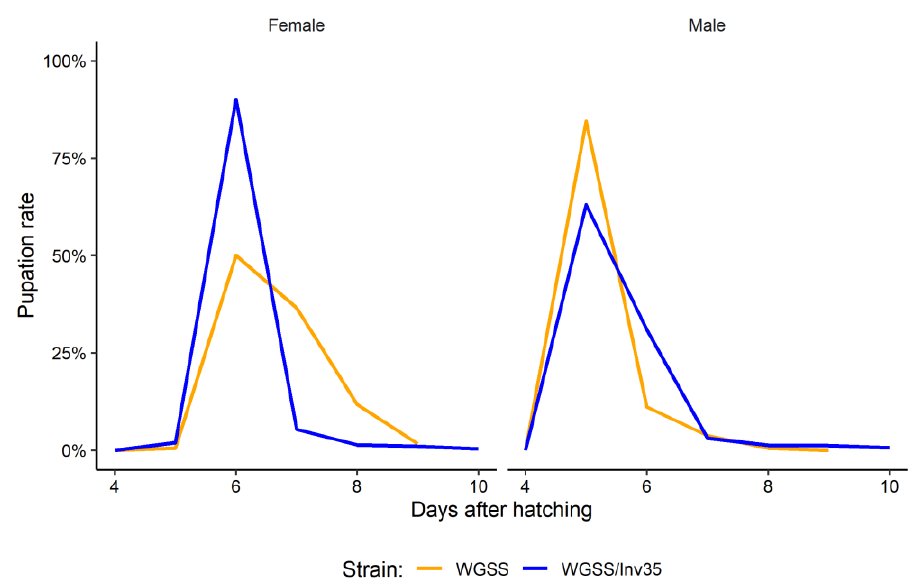
Figure 5. Pupation curves of females and males of WGSS and WGSS/Inv35. Three replicates were performed per strain. Statistical analysis was carried out using a GLM with binomial distribution. Pupal weight : No statistically significant difference was observed between males or females in both Ae. aegypti WGSS and WGSS/Inv35 regarding pupal weight, with females being heavier (approx. 42.4 mg per 10 pupae — Poisson GLM: Tukey contrasts 0.109, p =